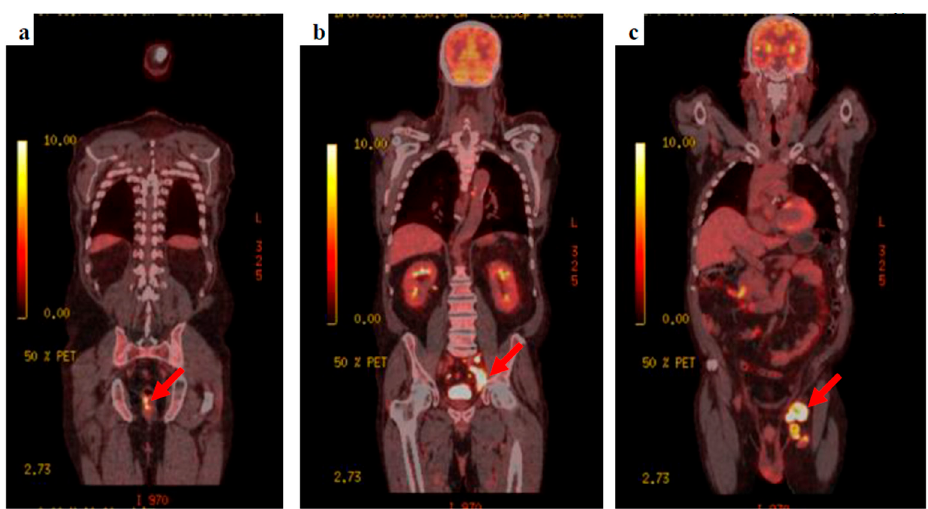
Figure 3. 18 F-FDG PET-CT images ( a ) the anorectal primary lesion with SUV max 12.2, ( b ) deep, left